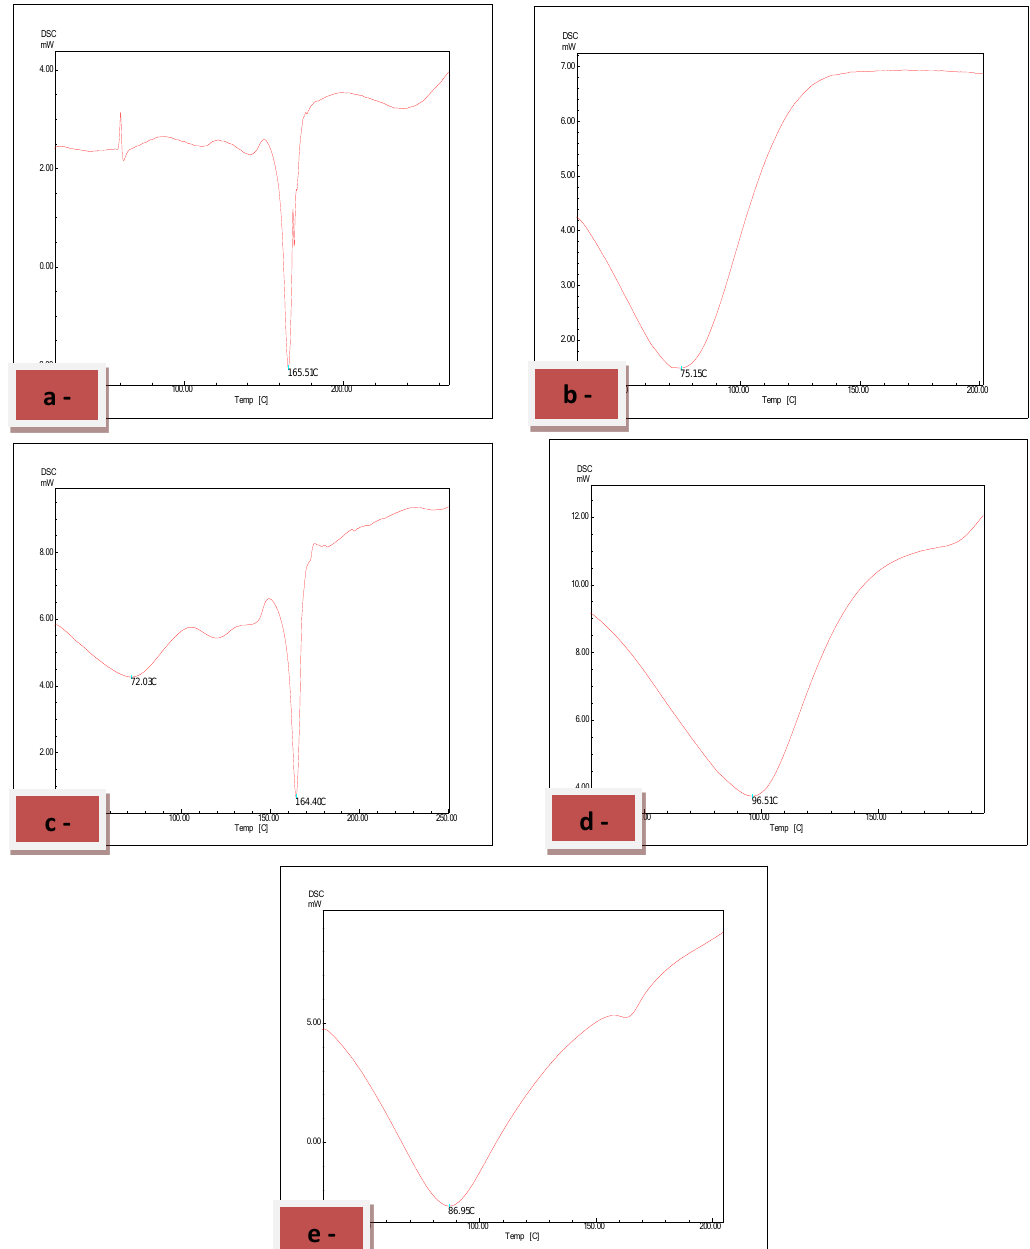
Figure 4: DSC thermograms of pure nystatin (a), chitosan (b), physical mixture of chitosan and nystatin (c), plain microparticles (d) and loaded microparticles (